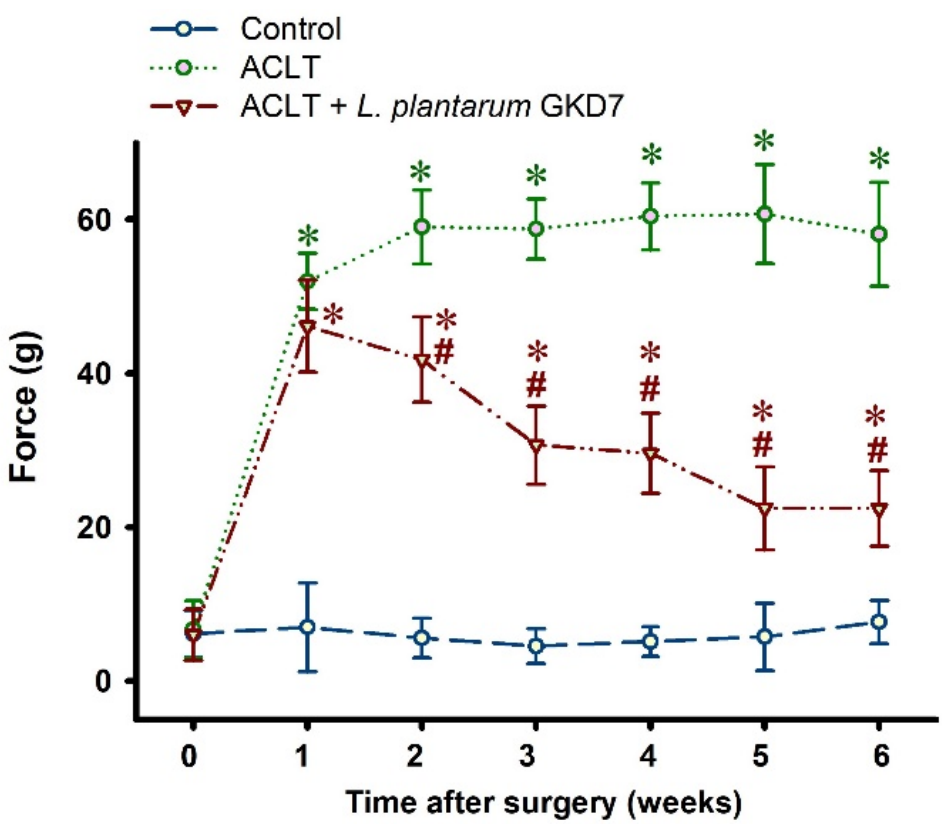
Figure 2. Oral live L. plantarum GKD7 improved weight-bearing deficits after ACLT surgery. Daily oral administration of live L. plantarum GKD7 was associated with significantly less weight-bearing asymmetry after ACLT surgery compared with ACLT-only rats. * p < 0.05 vs. controls; # p < 0.05 vs. the ACLT-only group.